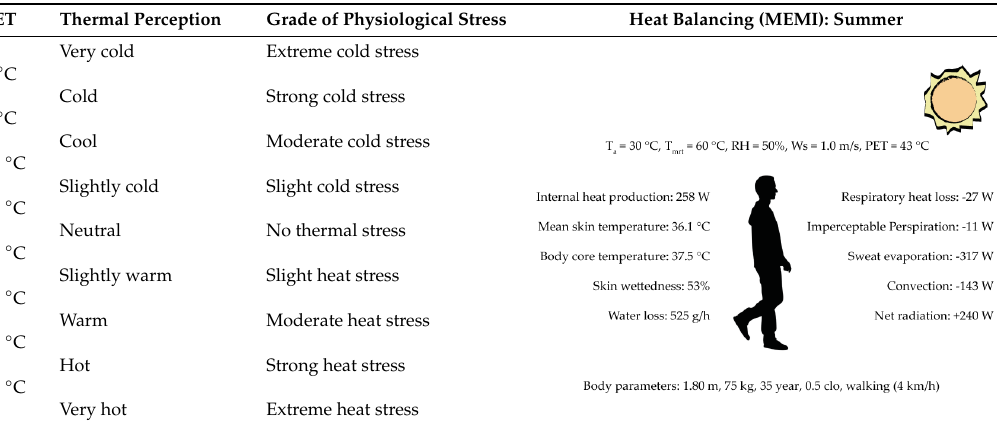
Table 2. PET level, thermal perception and grade of physiological stress according to [5,84]. On the right, a sample of heat balance calculation with the MEMI in summer (figure modified from [6].).